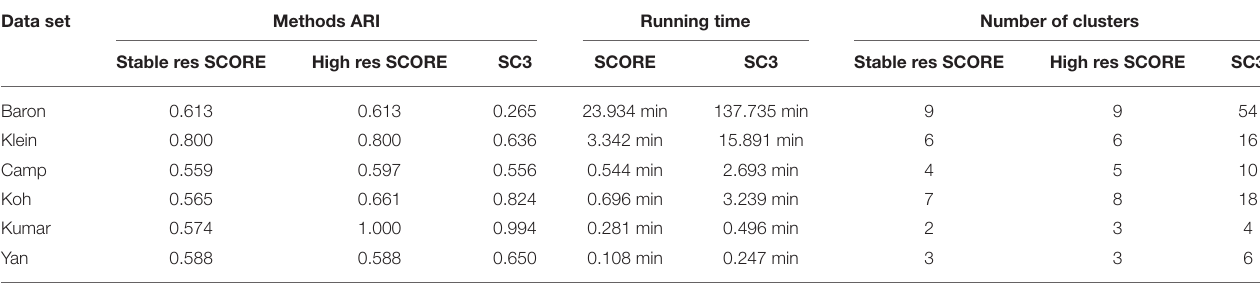
TABLE 1 | Benchmarking of clustering results and running time. Data